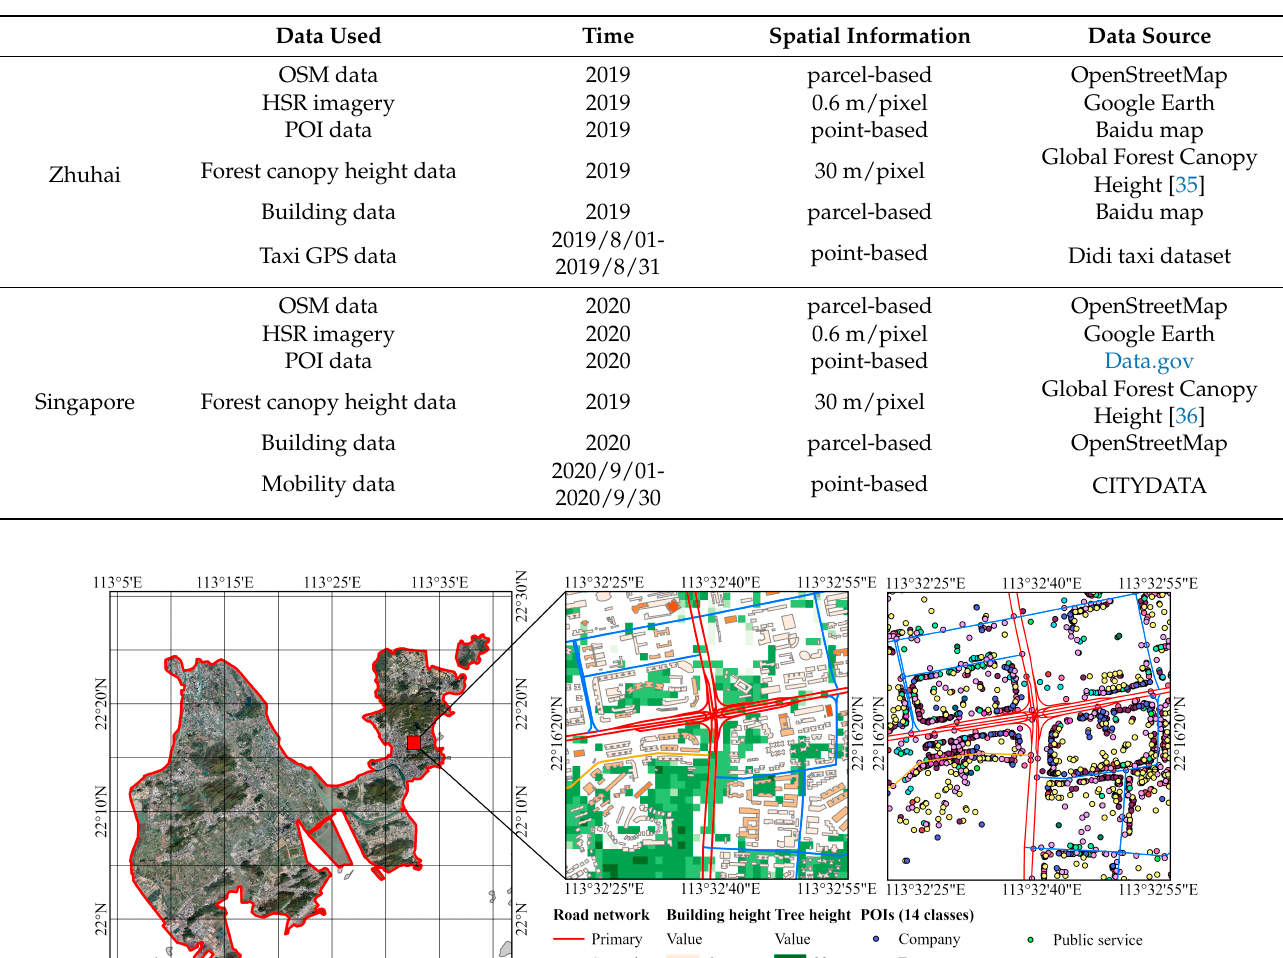
Table 1. Data sources.